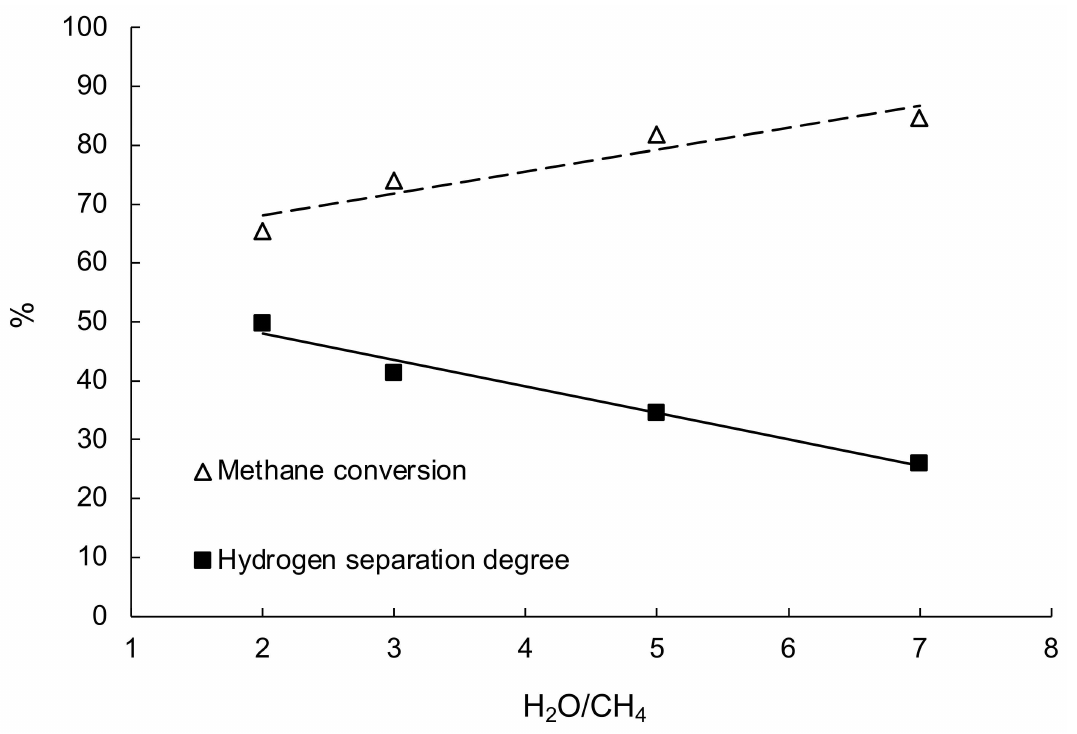
Figure 10. Dependence of methane steam reforming and the degree of extraction of ultrapure hydrogen on the H 2 O/CH 4 molar ratio (T = 700 ◦ C).